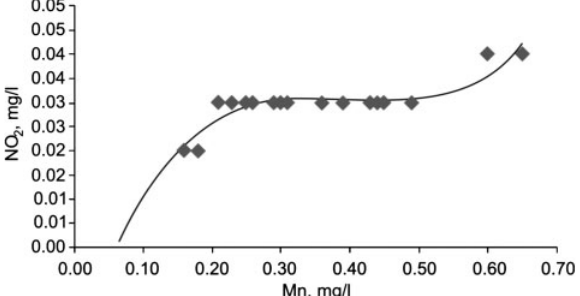
Fig. 5. Dependency between manganese and nitrite concen- trations in Vilnius network sampling points